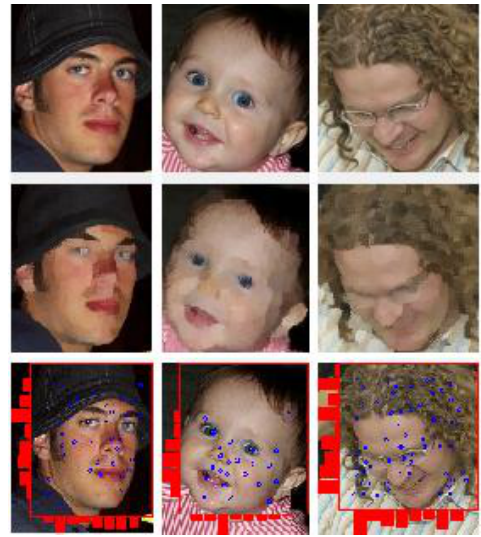
Figure 3. Scaled fragments with increased number of G-SURFs